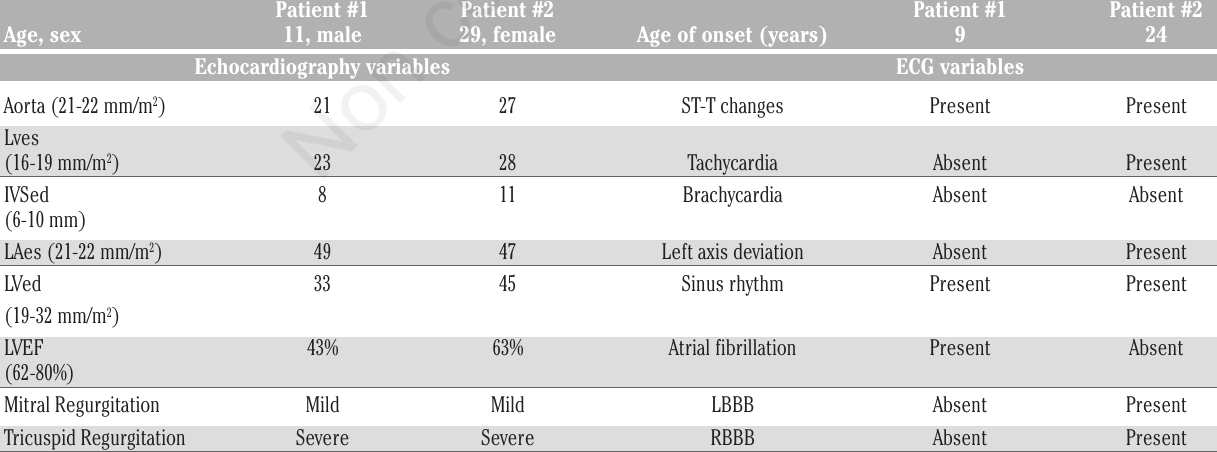
Table 1. Echocardiographic and ECG variables of patients.